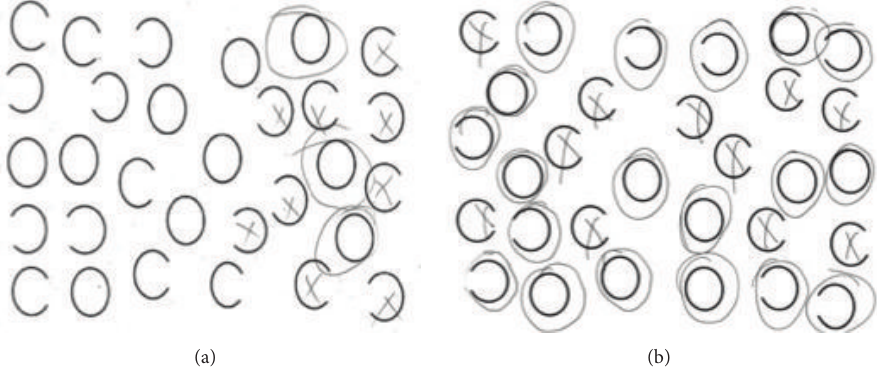
Figure 1: Contrasting performance of patients with viewer-centered and stimulus-centered neglect on the gap-detection test [24] (in this task the patient is asked to circle all the complete circles and put an X over circles that have a gap on the left or right side). (a) Performance by a patient with a right frontoparietal stroke and viewer-centered neglect on the gap-detection test. Note that he misses all of the stimuli on the left side of the view but detects left gaps in circles on the right view. (b) Performance by a patient with a right temporal stroke and stimulus-centered neglect on the gap-detection test. Note that he fails to detect the left gaps in circles on the right and left sides of the view.